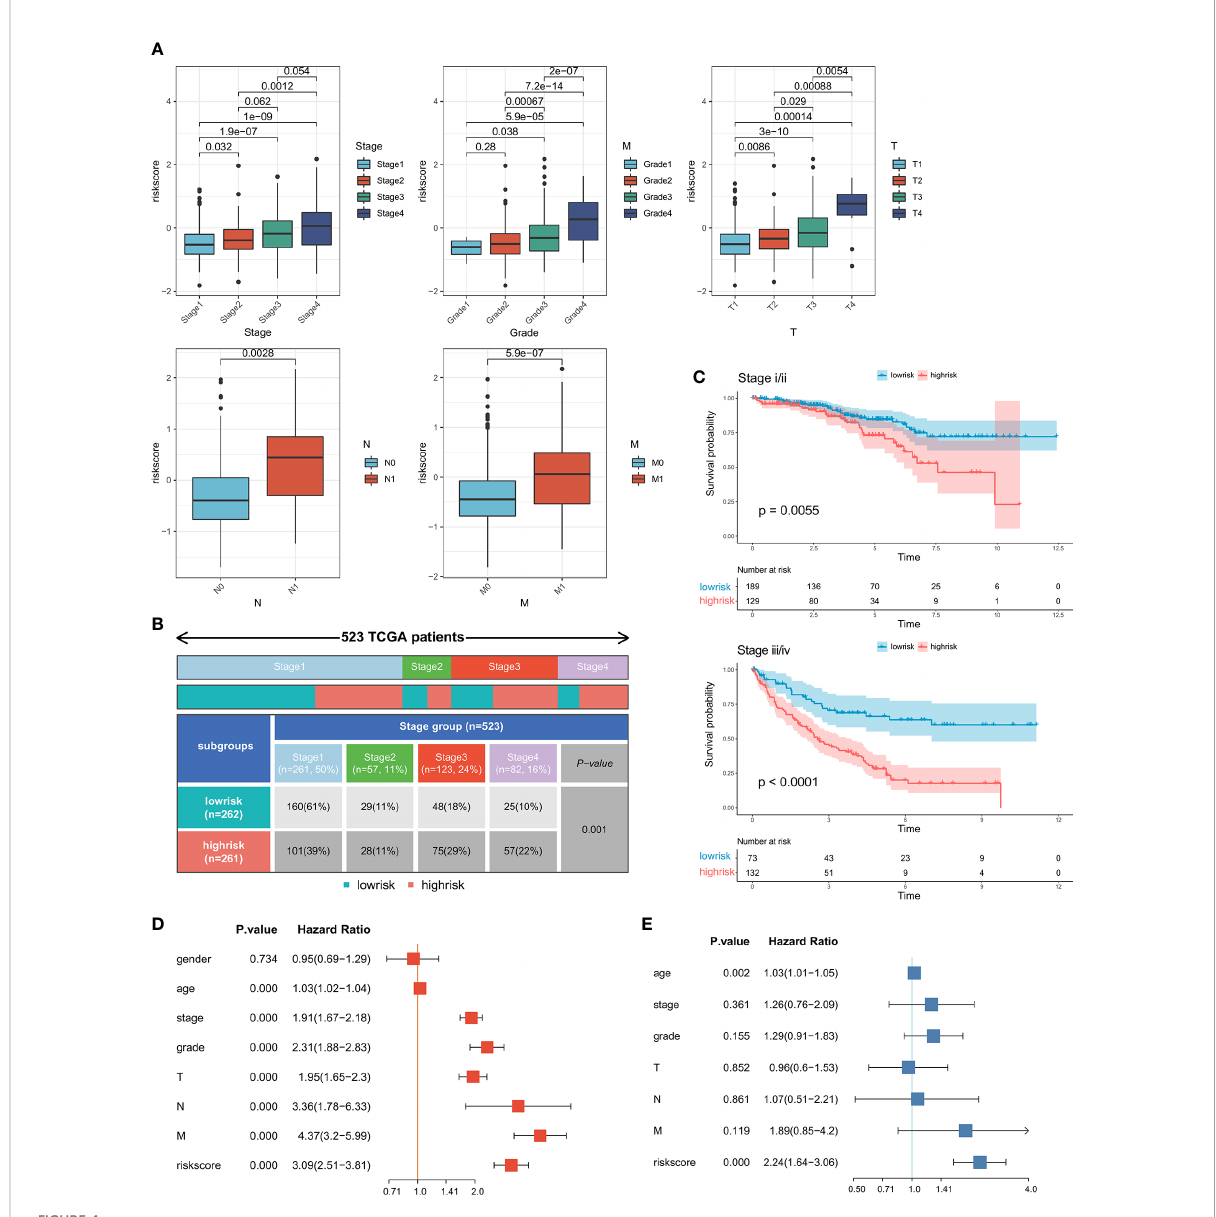
FIGURE 4 Association between the predictive signature and clinical parameters: (A) Correlations between riskscore and progression of ccRCC. (B) The proportion of patients in different stages between the high- and low-risk groups. (C) Kaplan-Meier survival curves of OS in early and advanced patients. (D) Univariate and (E) multivariate Cox regression analyses of correlations between the riskscore and clinical